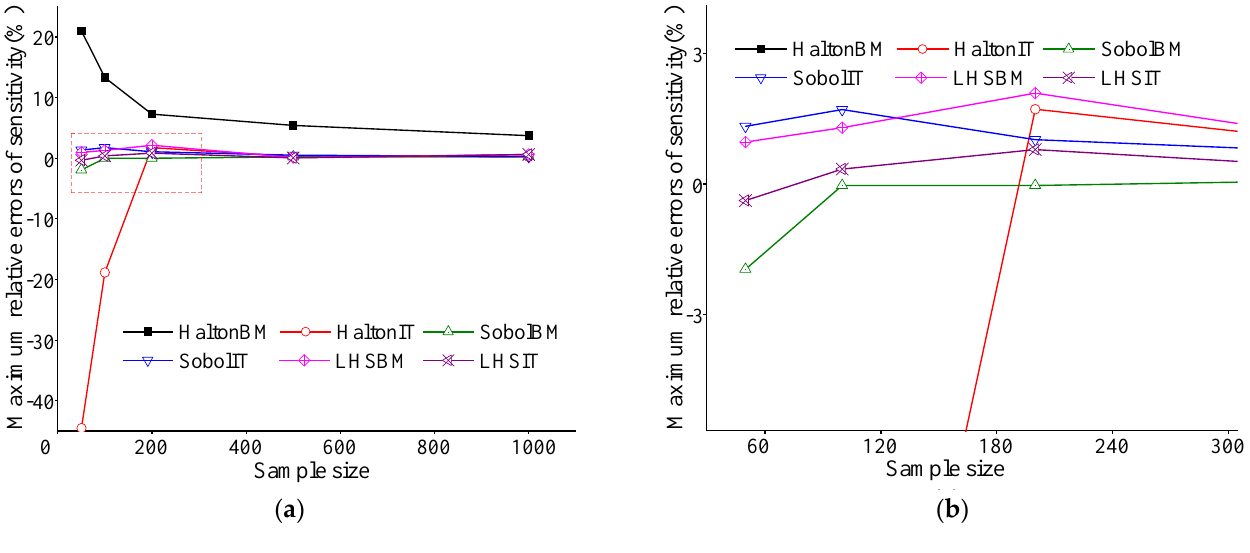
Figure 9. ( a ) Trend of maximum relative error of sensitivity with sample size 𝑁 in Example 4 and ( b ) its local magnification